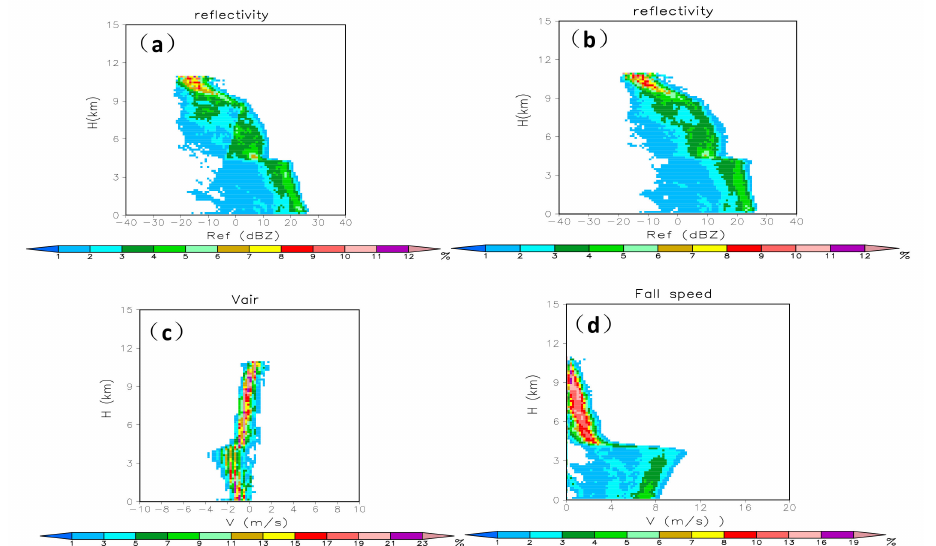
Figure 7. Normalized contoured frequency by altitude diagrams (%) of recalculated reflectivity ( a ) before and ( b ) after attenuation correction, ( c ) vertical air speed, and ( d ) corrected hydrometeor fall speed to ground on May 21,